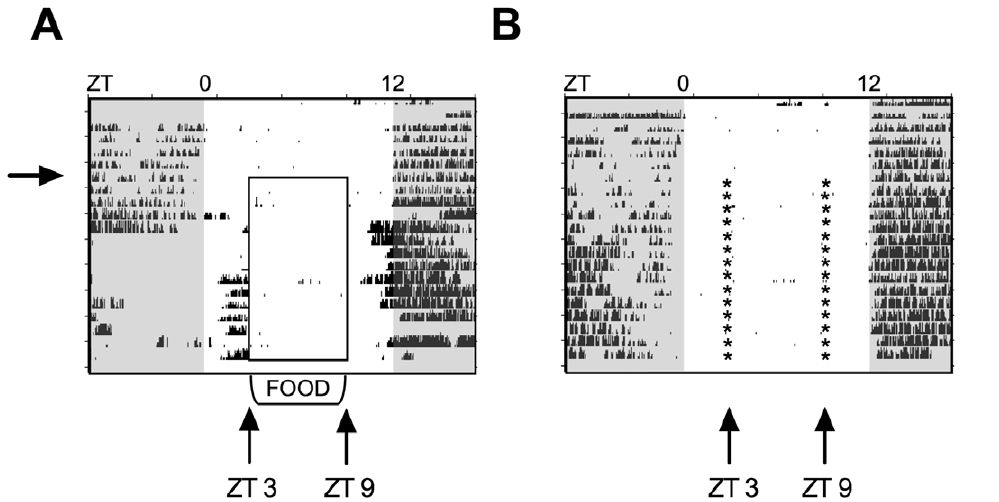
Figure 2. Wheel-running actograms of restricted fed or adlibitum fed C57BL/6 mice. ( A ) Restricted fed mice. Each horizontal line of the actogram represents a twenty-four hour period, and each tick mark on the graph represents one running-wheel revolution. Lights off are indicated by the shaded areas of the actograms. Mice were habituated to a 12:12 LD cycle for 7 days with ad libitum access to food. At ZT9 on Day 7 (marked by the arrow), food was removed from the cages. At ZT3, a small bowl containing food was placed in the bottom of the cage. At ZT9 the food was removed. This was repeated daily until the conclusion of the experiment on Day 21. Food availability is marked by the open box. This actogram is a representative example from an individual mouse. ( B ) Ad libitum fed controls. Actogram is as described in (A). Mice were habituated to a 12:12 LD cycle for 7 days. On day 8, small bowls of food were placed into the cages, and food was moved in and out of the bowl at ZT3 and ZT9, respectively. Controls were maintained on ad libitum feeding throughout the study, but on day 8 small bowls of food were placed into the cages, and food was moved in and out of the cage in the same manner as the restricted fed mice. Times food bowls were moved in and out are represented by *.